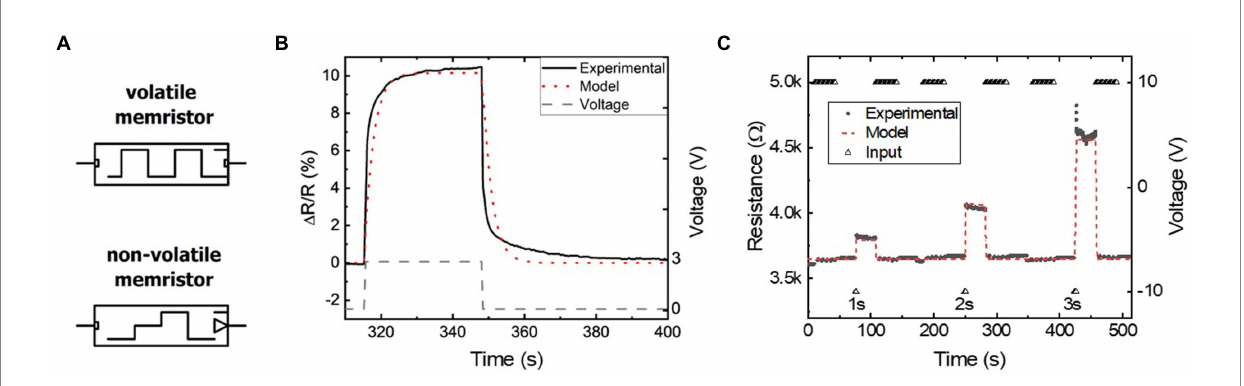
FIGURE 1 (A) Circuit symbols for the volatile (top) and non-volatile (bottom) memristor packaged in SPICE. (B,C) Parameter extraction used to match experimental (B) volatile and (C) non-volatile memristors and their time-dependent